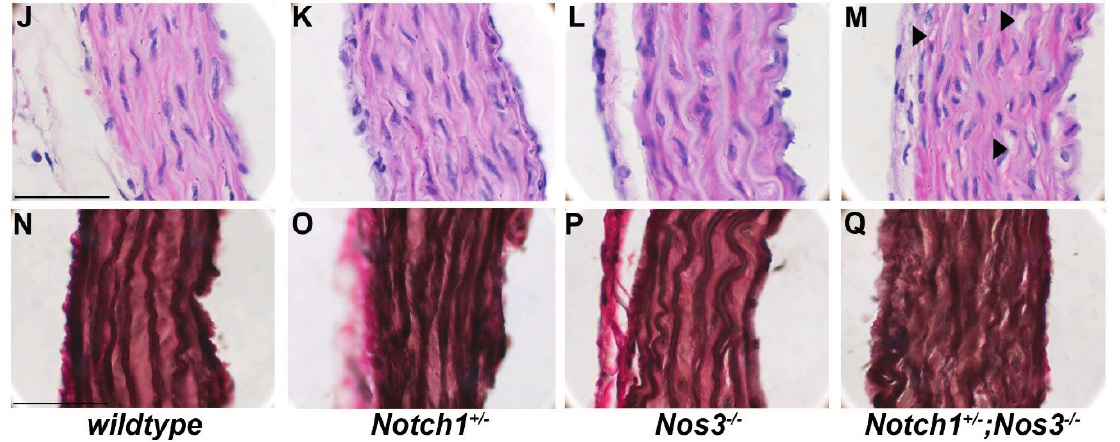
Figure 3. Dilation of proximal ascending aorta in Notch1 +/ − ; Nos3 − / − mice. Representative gross images of thoracic aorta at 8 months are shown in ( A – D ); ( E ) Quantification of gross aortic root diameter showing a trend for dilation in Notch1 +/ − ; Nos3 − / − mice ( n = 4 per genotype); N.S., not significant; ( F – M ) Hematoxylin and eosin stained aortic sections at 400x and 1000x, respectively ( F – I , J – M ), showing areas of presumed SMC loss in Notch1 +/ − ; Nos3 − / − ( M , arrowheads). ( N – Q ) Representative images of elastin stained aortic cross sections at 1000x, illustrating degraded elastin in the Notch1 +/ − and Notch1 +/ − ; Nos3 − / − mice. Scale bar equals 50